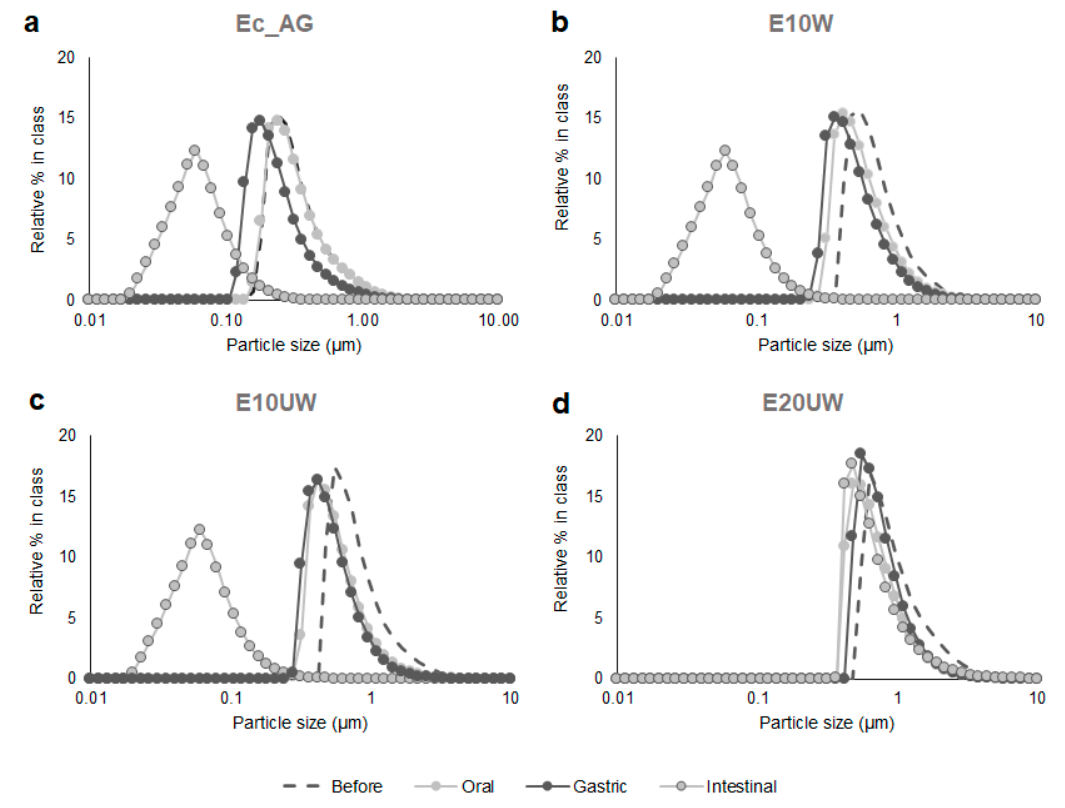
Figure 1. Effect of in vitro digestion on the number weighted particle size distributions of SO reconstituted emulsions stabilized with AG ( a ), β -glucan-rich extracts washed ( b ), and unwashed ( c , d ). Sample codes are explained in Section 2.2.1. Results presented are representative data for three separate experiments.